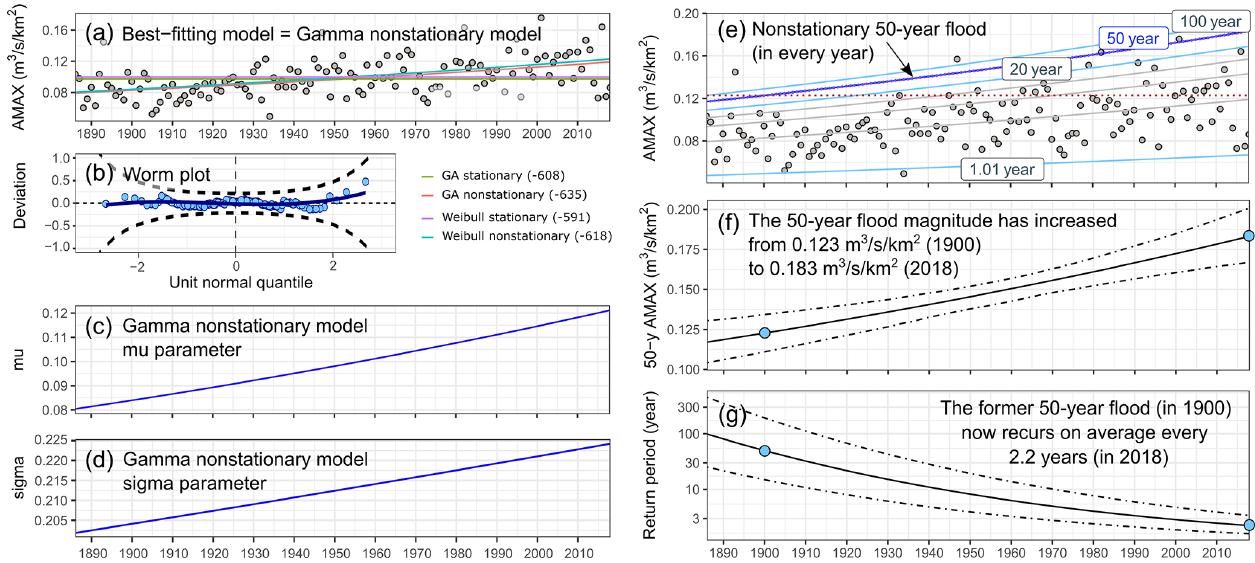
Figure 6. Example workflow for detecting trends in the magnitude and return period of extremes using distributional regression (GAMLSS). The example shows a considerable increase in flood magnitude and frequency in the River Ouse in Skelton, UK, over 130 years. (a) In total, two nonstationary and two stationary models are fitted to the time series of 15min peak maxima (black circles – specific discharge in cubic metres per second per square kilometre); colour lines indicate the 50% probability (centile) for each model. The best-fitting model is the nonstationary Gamma model (lowest Schwarz Bayesian criterion, indicated in parentheses). (b) The worm plot indicates a satisfactory model fit (dashed lines indicate 95% confidence interval). (c) Time series of the µ parameter for the nonstationary Gamma model. (d) Time series of the σ parameter (note that the mean of the distribution is equal to µ , and the variance is equal to σ 2 µ 2 ). (e) Centile curves for the best-fitting nonstationary model are shown for the 1st, 50th, 80th, and 90th centiles (from bottom to top), 95th (20-year flood), 98th (50-year flood), and 99th (100-year flood). The dotted horizontal red line indicates the value of the 50-year flood in 1900. (f) The 50-year flood estimated every year from the nonstationary model increases over time. Confidence intervals given by dashed lines (5th and 95th). Blue circles indicate the estimated 50-year flood in 1900 and 2018. (g) The return period of the 50-year flood estimated in 1900 (with associated confidence intervals in 1900) is then estimated for every year using time-varying µ and σ parameters. Blue circles indicate the estimated return period in 1900 (50 years) and